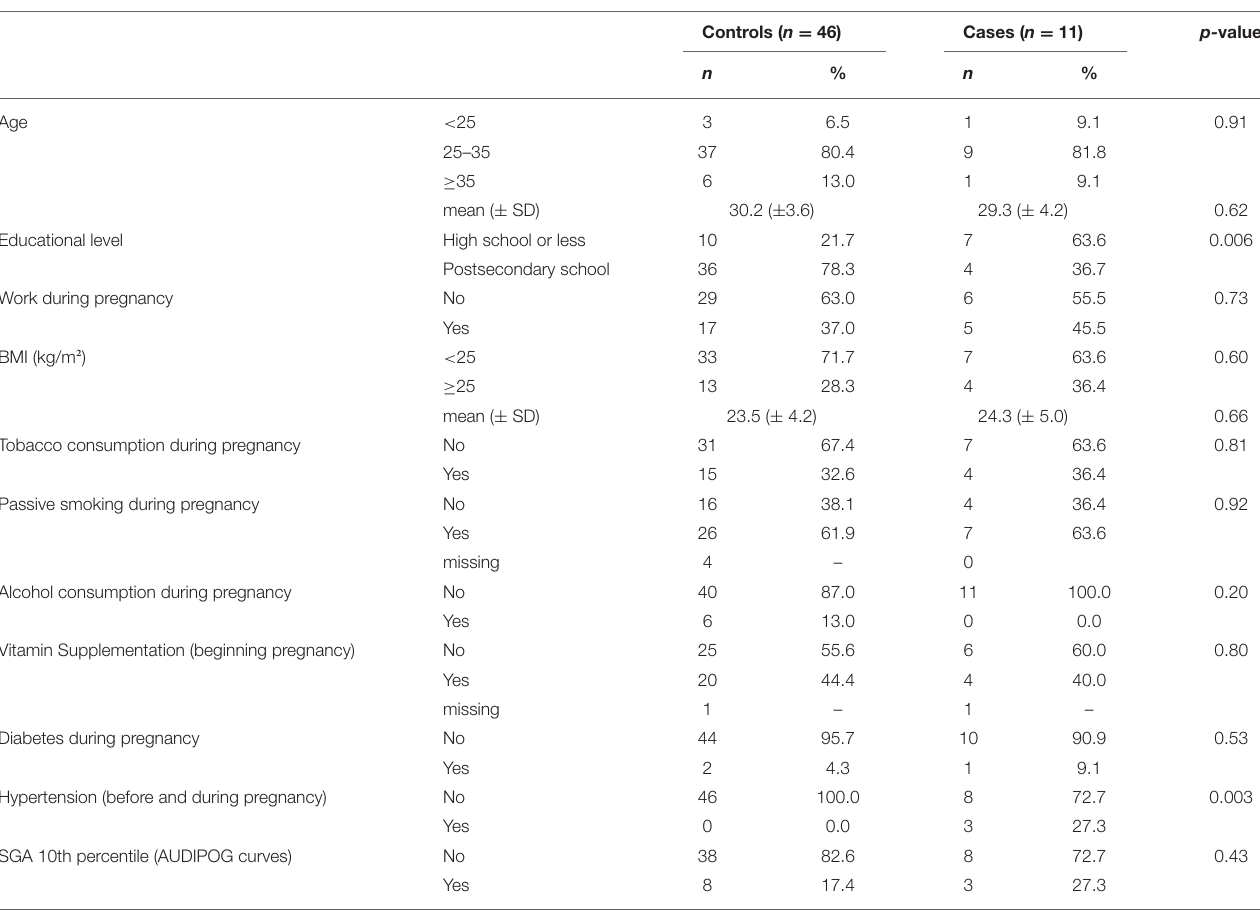
TABLE 1 | Characteristics of the 11 cases of hypospadias and 46